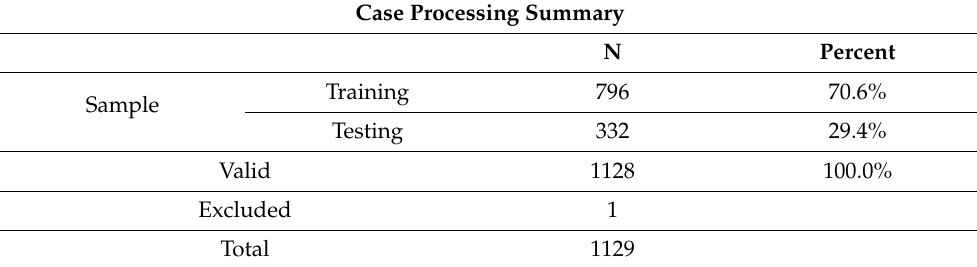
Table 12. Training and Testing.